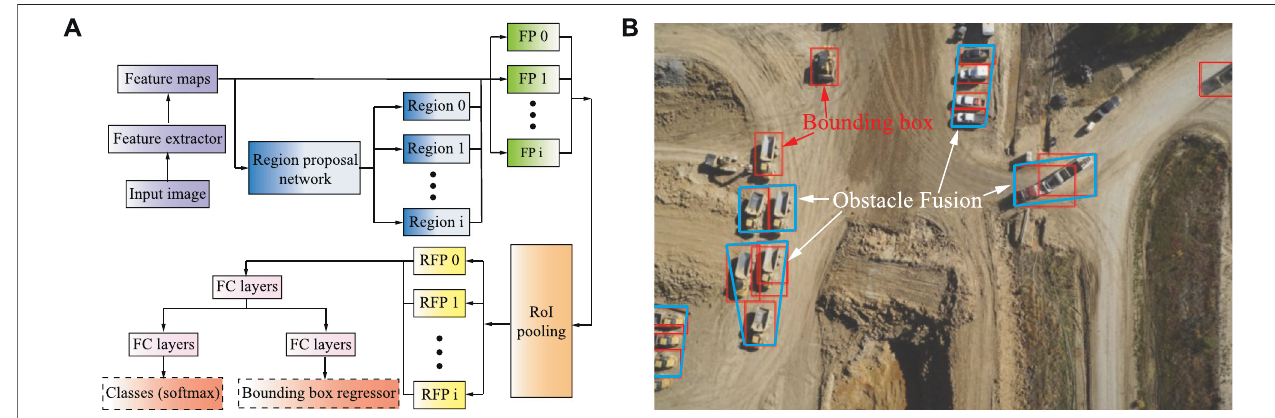
FIGURE 4 | (A) Schematic illustration of the faster region-based convolutional neural network (Faster R-CNN) object detection method. (B) The obstacle approximation for a real map. Red boxes are the bounding boxes for object detection, and the green boxes are the approximation of the